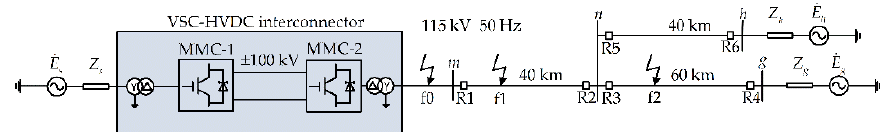
Figure 1. Model of an AC/DC hybrid system.